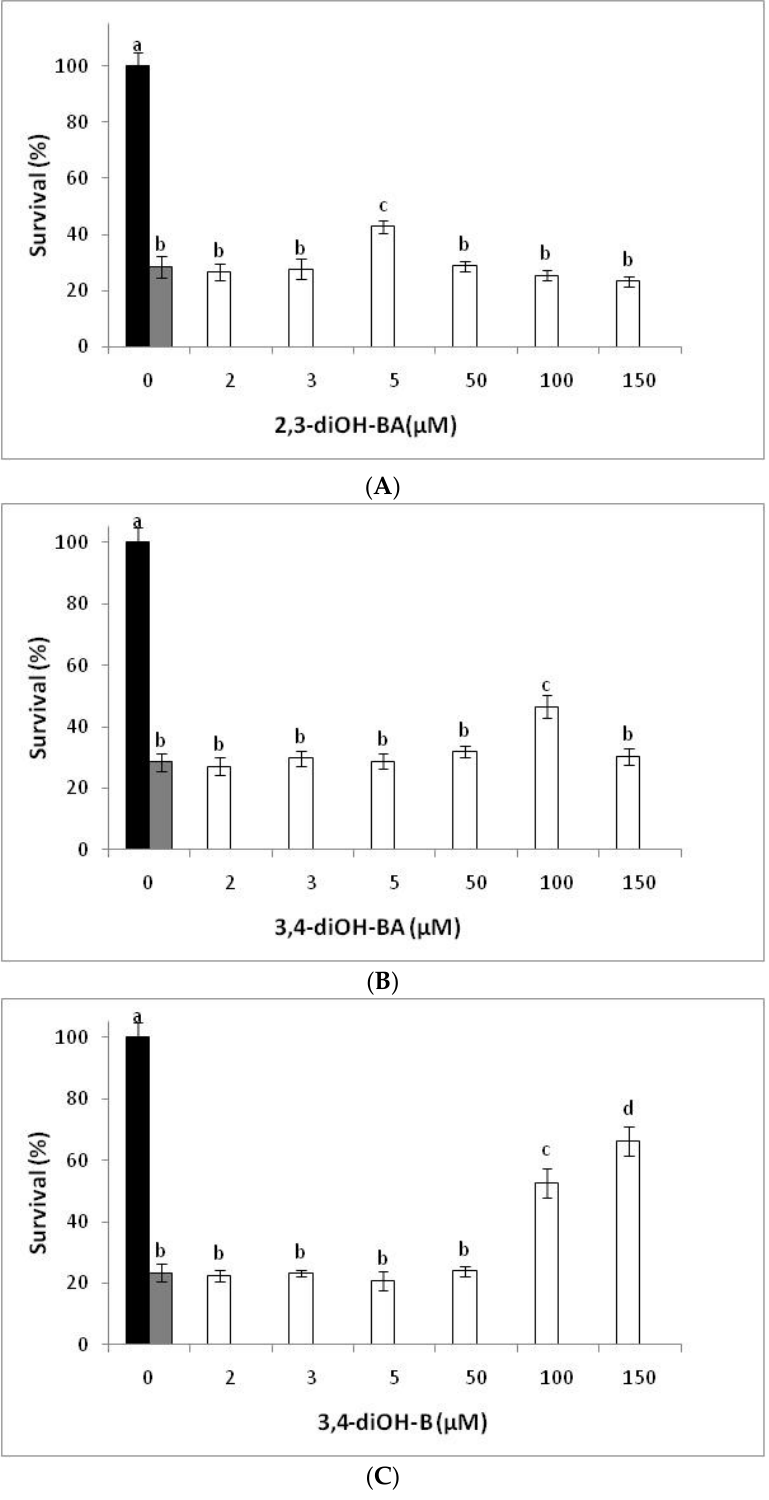
Figure 2. Effect of the tested phenolic compounds on survival rates of S. cerevisiae BY4741 cells treated with CumOOH (150 μ M). Black bar means untreated cells, gray bar means cells treated only with CumOOH and white bars mean cells treated with CumOOH +2,3-diOH-BA ( A ), 3,4-diOH-BA ( B ), and 3,4-diOH-B ( C ). Data represent the mean values ± SD of at least three independent experiments. Different lowercase letters above the bars indicate a statistically significant difference at p < 0.05.